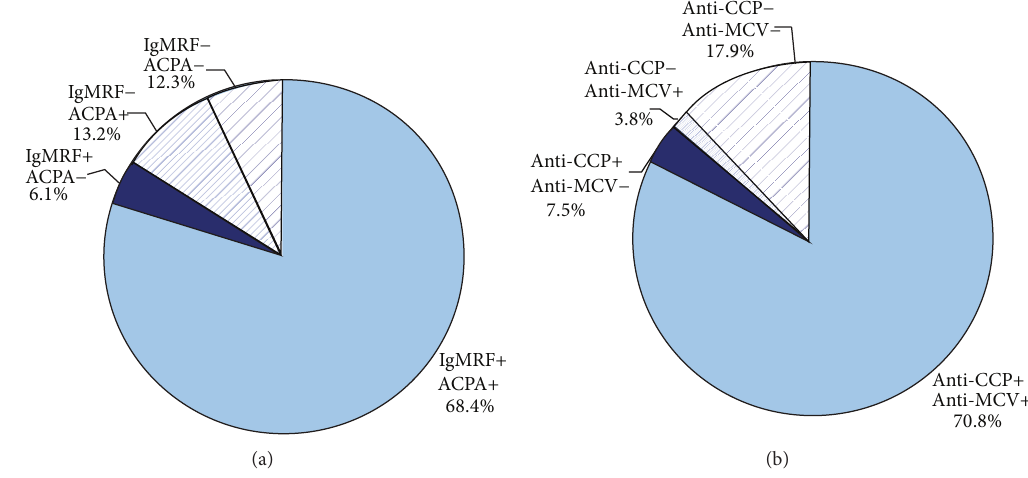
Figure 2: Dividing patients into groups, depending on the level of antibodies; “+”: positive level and “ − ”: negative